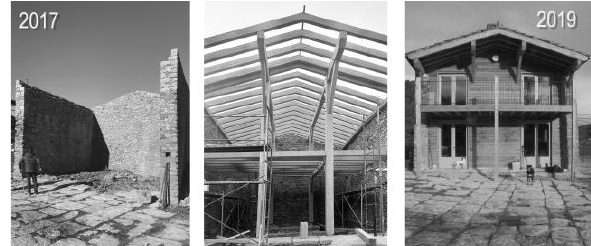
Figure 11. Evolution of the construction of the owner's